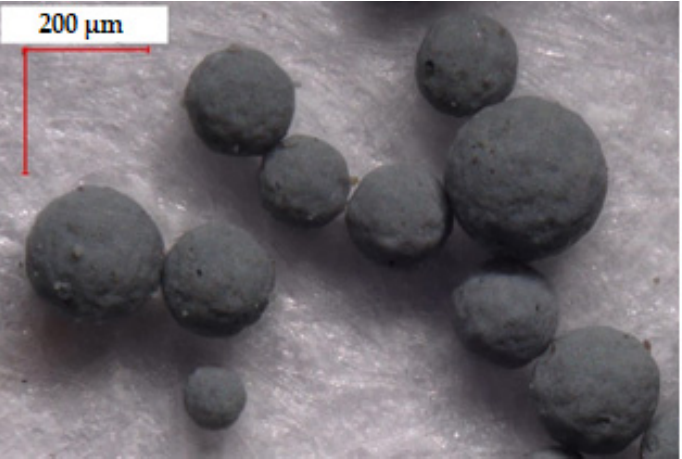
Figure 1. Silica agglomerate, magnification 200× (Keyence VHX ‐ 7000) .